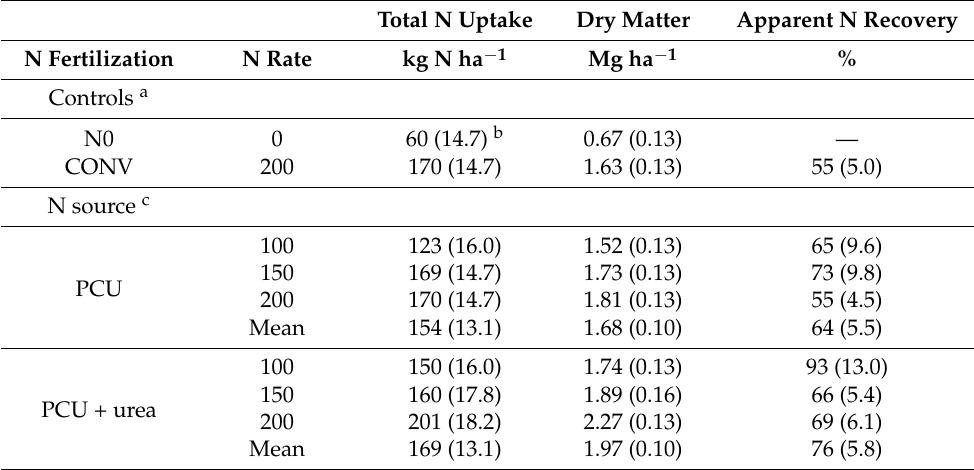
Table 6. Effect of N treatment on total N uptake, aboveground dry matter and apparent N recovery averaged over irrigation